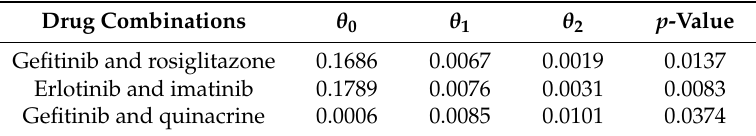
Table 2. Local optimization